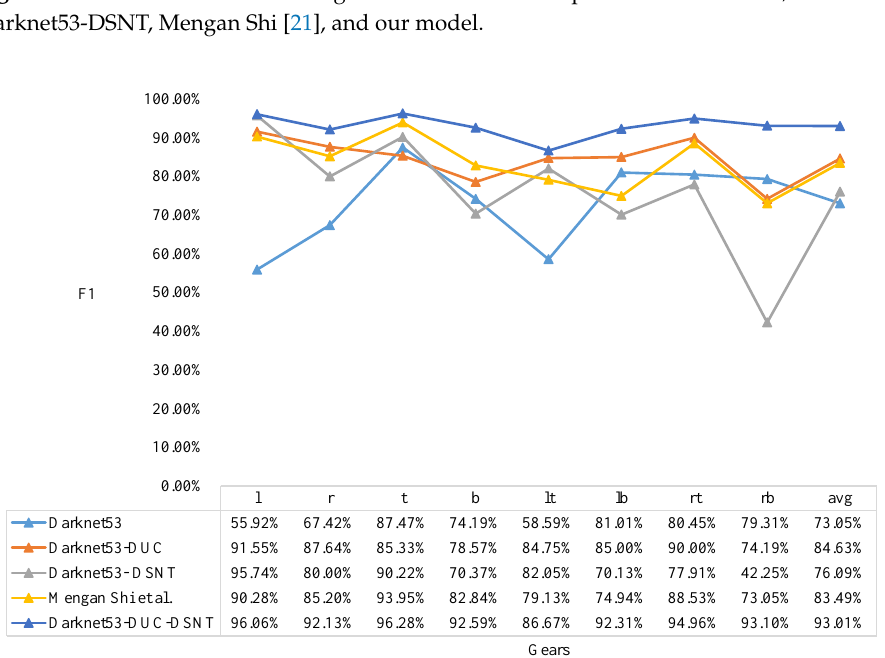
Figure 14. F1 results of knob gear classification. Comparison of Darknet53, Darknet53-DUC, Darknet53-DSNT, Mengan Shi [21], and our